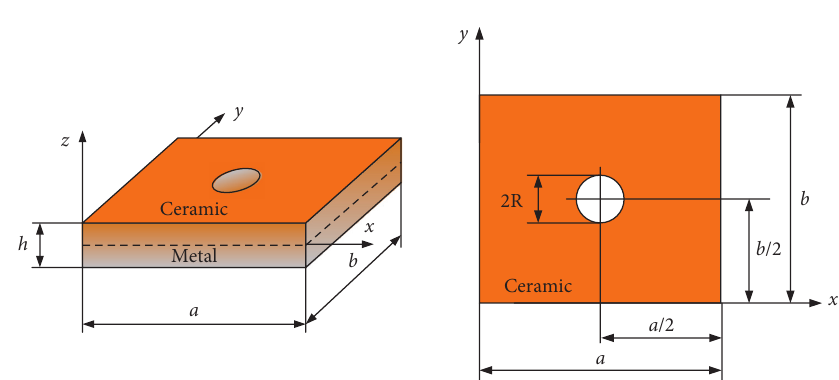
Figure 7: An FGM nanoplate with a circle